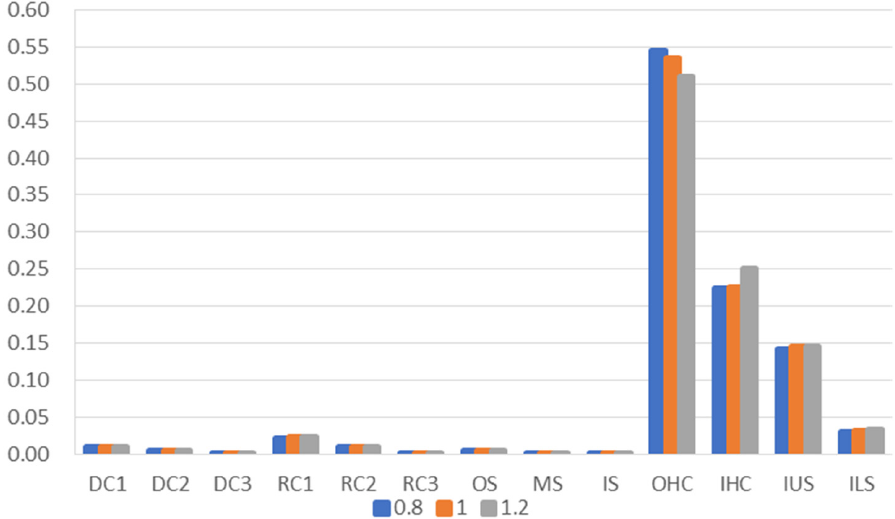
Figure 8. Importance coefficients of different elements under different radius of the inner hoop cable